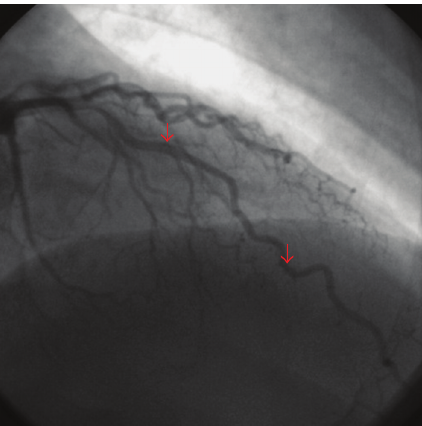
Figure 1: Coronary angiogram showing slight systolic compression of LAD.